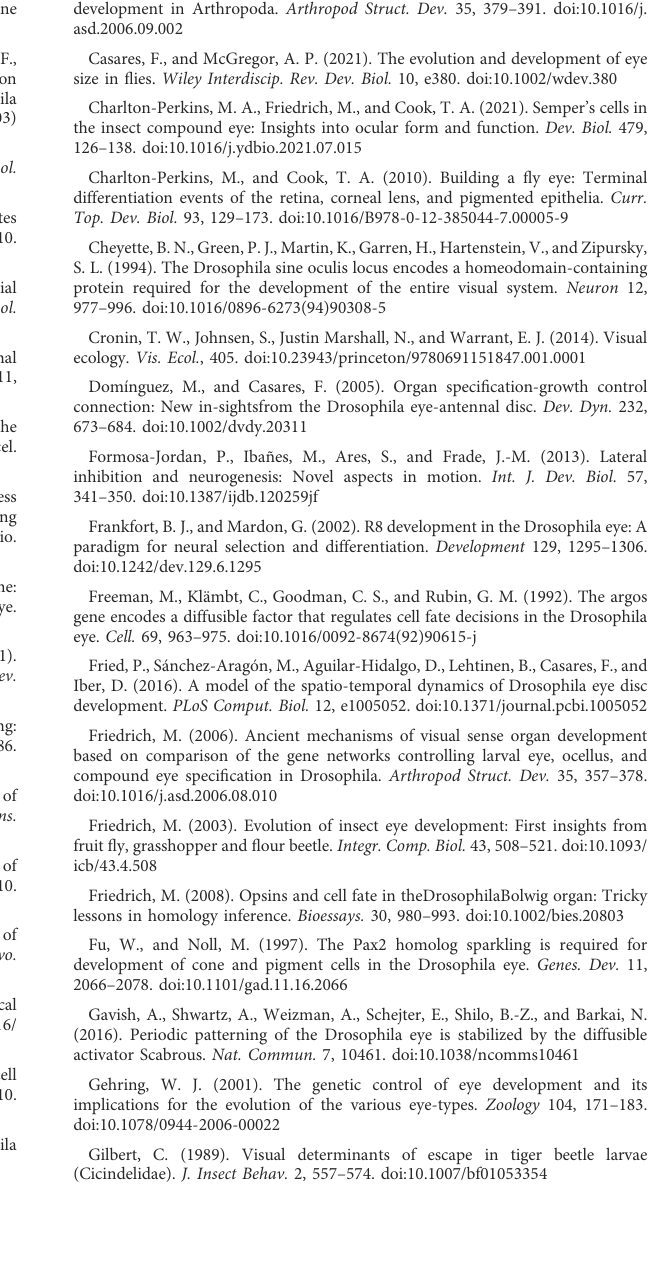
Figure 5. Values that differ from those for compound eye construction are indicated in